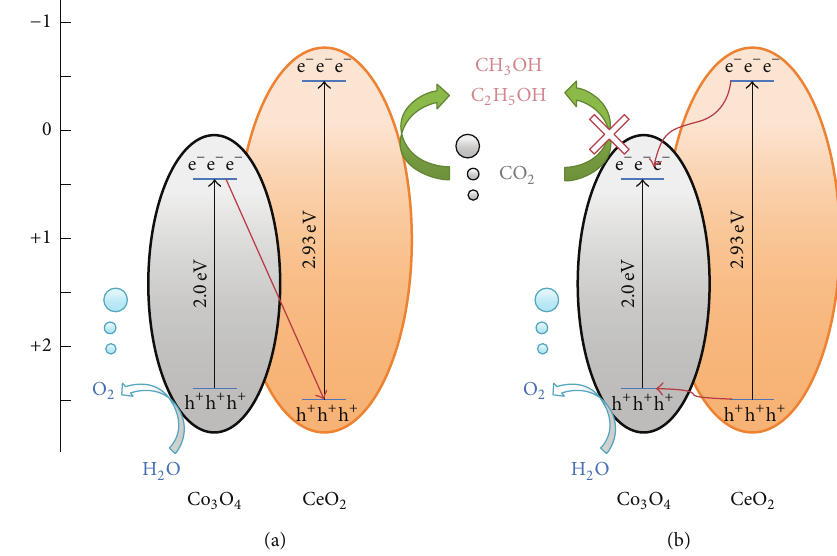
Figure 11: The scheme of photocatalytic reduction of carbon dioxide with water to methanol and ethanol.